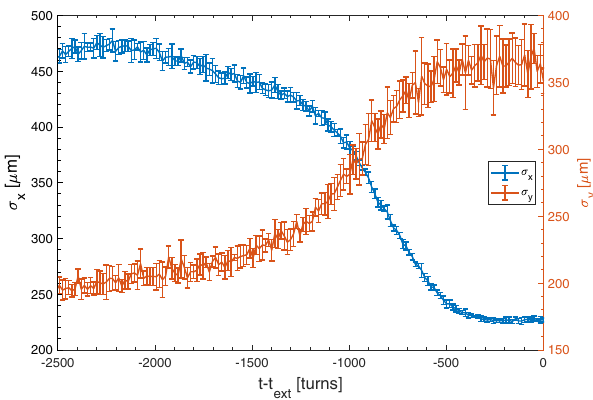
FIG. 14. Beam size measurements for various extraction kicker delays. The beam sizes are measured with an OTR screen installed in the booster-to-ring transfer